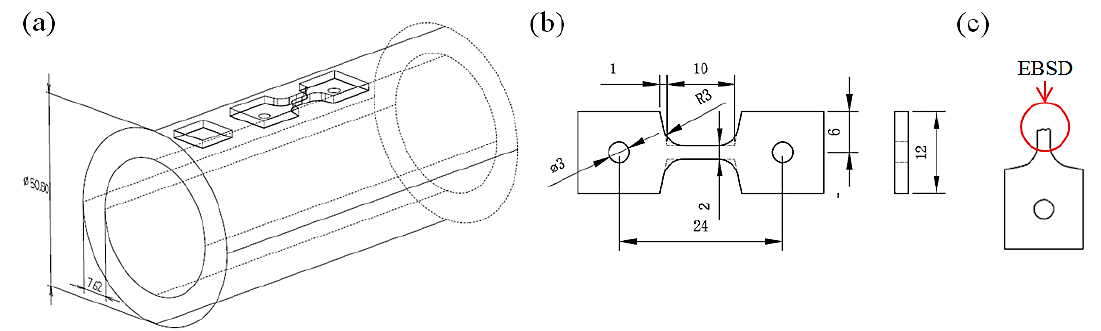
Figure 1. Schematic diagrams showing ( a ) tested samples cut from the Gr.91 steel tube, ( b ) the specimen dimensions for creep test, ( c ) the fractured zone cut from crept sample for EBSD analysis.